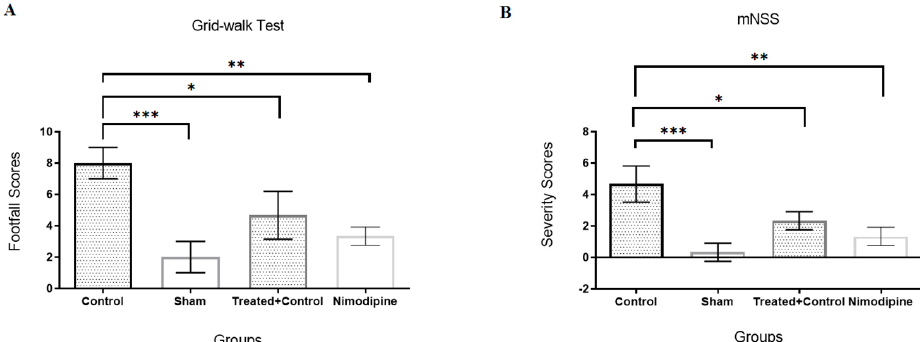
Figure 1. Behavioral tests in rats. ( A ): Grid-walking test, ( B ): modified neurological severity scores (mNSS) test. Data are mean ± SEM. * p < 0.05, ** p < 0.01 , *** p < 0.001.